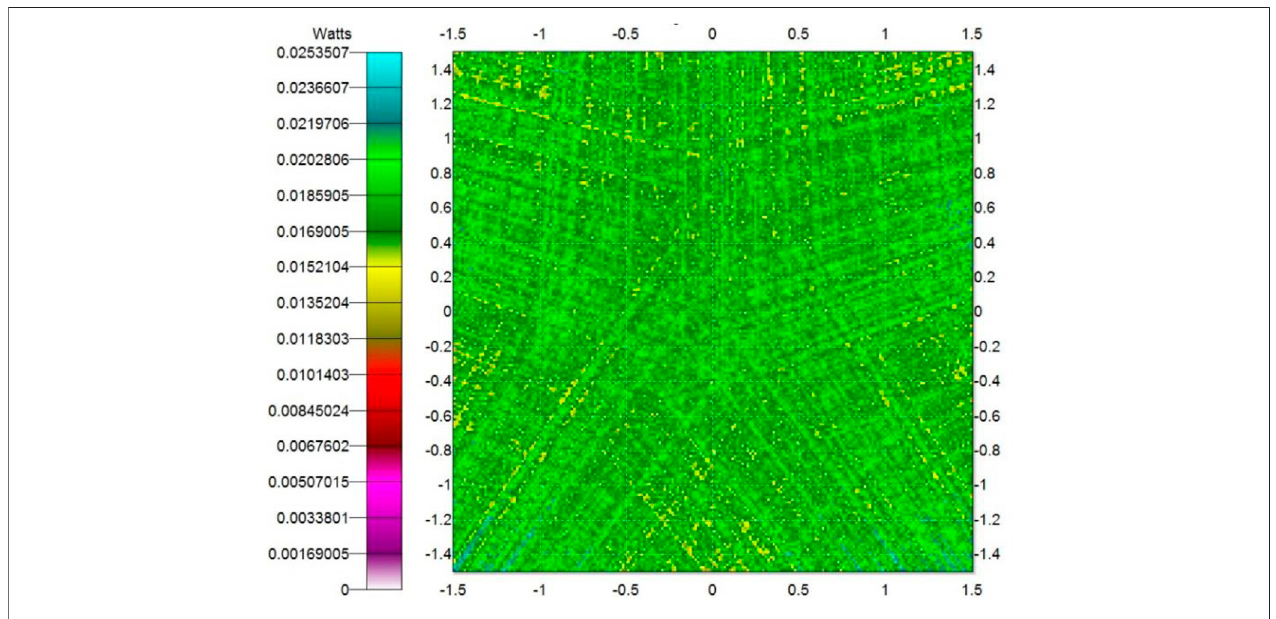
FIGURE 5 | Pumping distribution of LH.